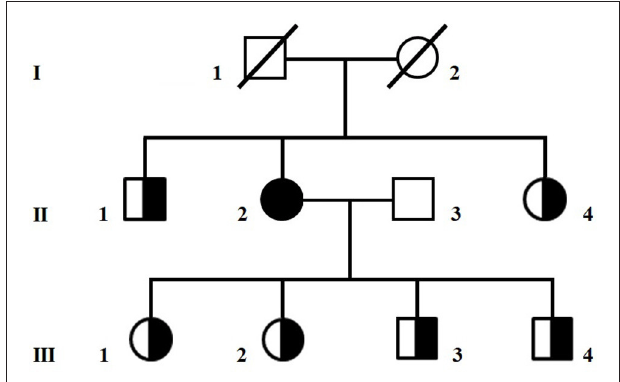
FIGURE 1 | Pedigree of the family. Circles are women and squares are men. A shaded symbol indicates the proposita, half-shaded symbols indicate asymptomatic carriers of the homoplasmic m.8393C > T/p.Pro10Ser variant in MT-ATP8